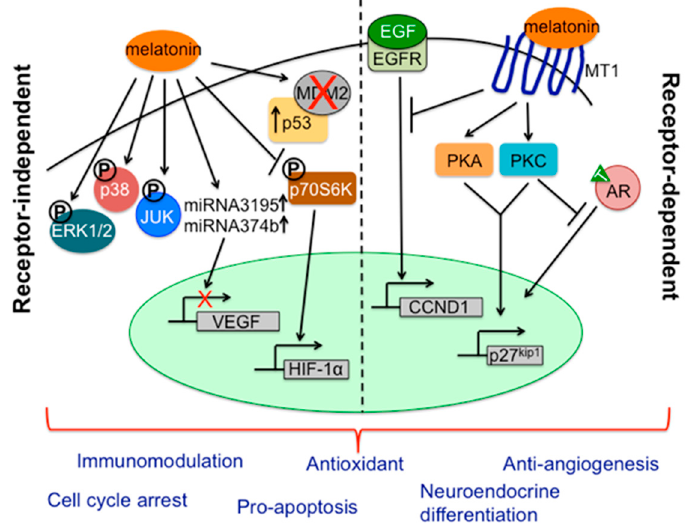
Figure 6. Mechanisms of melatonin’s oncostatic action during prostate cancer progression; these are either independent of the functions of melatonin receptors ( left ) or mediated via specific interaction of the indoleamine with its receptors ( right ). Multiple signaling cascades are induced or inactivated in prostate cancer cells upon melatonin treatment, which results in a variety of biological effects of the pineal secretory product. See text for additional details. T, testosterone; P, phosphorylation.